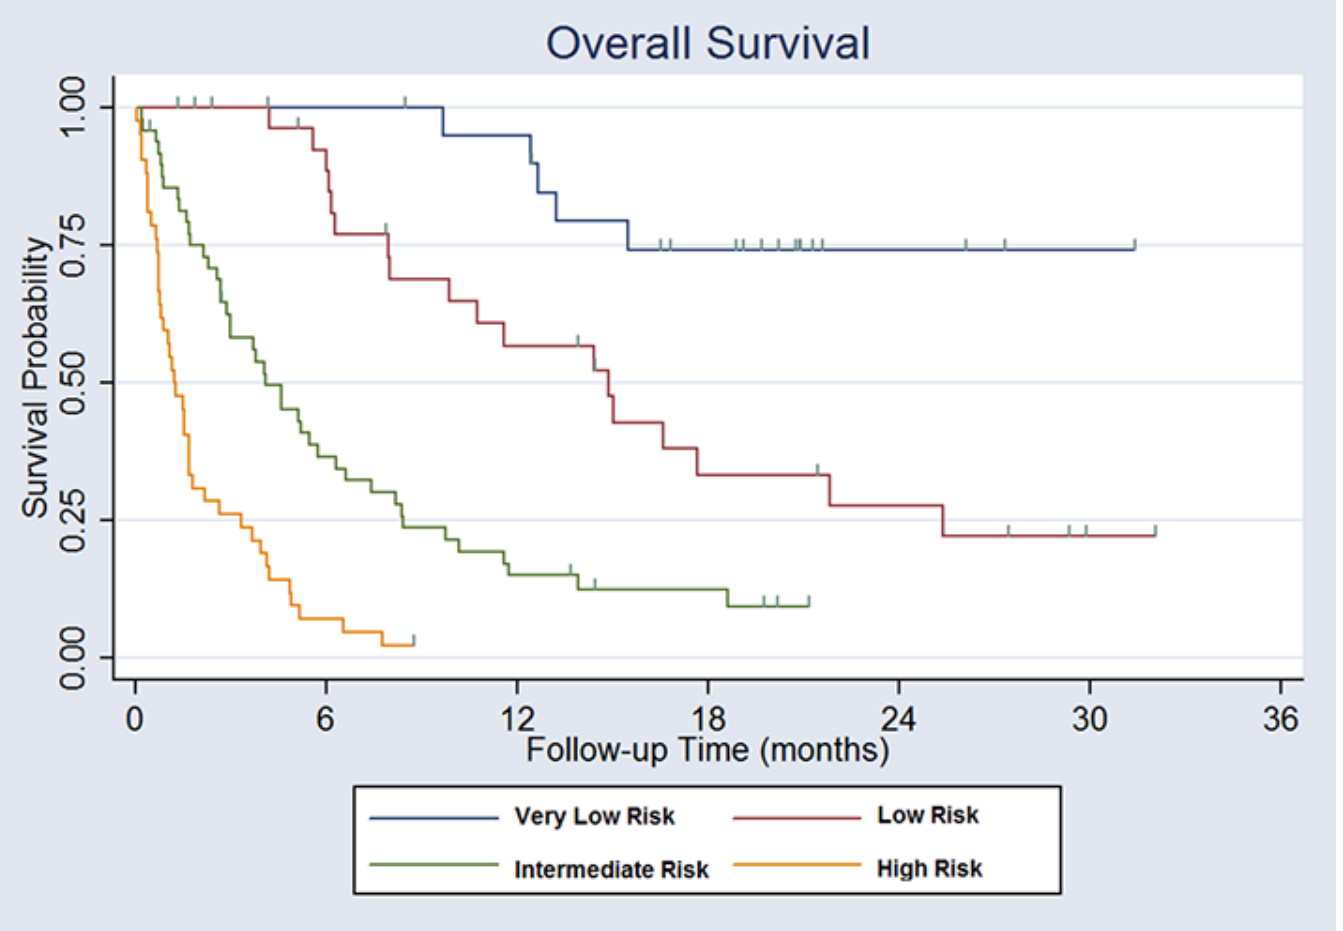
Fig 1. Overall Survival Stratified by Risk Score. Very low risk patients have a risk score of 0 to 1. Low risk patients have a risk score of 1.5 to 2. Intermediate risk patients have a risk score of 2.5 to 3.5. High risk patinets have a risk score of (cid:1) 4. Patients receive 1 point for serum albumin < 2.4, ECOG performance status 2, (cid:1) 6 active tumors or primary site other than breast, kidney or prostate. Patients receive 2 points for ECOG performance status 3 to 4 and 0.5 points for serum albumin 2.4 to 3.3.